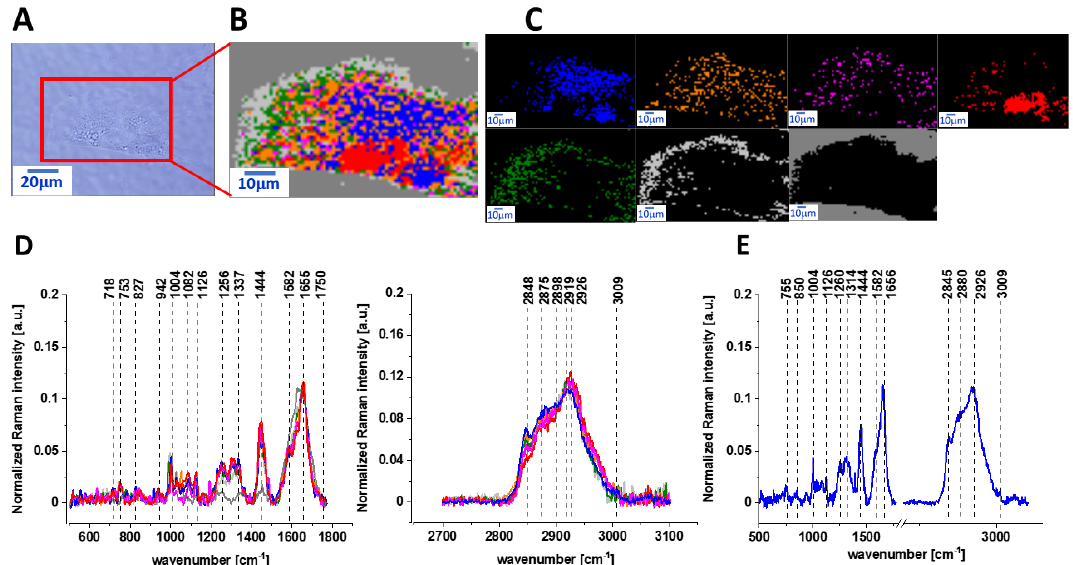
Figure 1. The microscopy image ( A ), Raman image ( B ) of human colon normal single cell CCD-18 Co constructed based on cluster analysis (CA) method; Raman images of all clusters identified by CA assigned to lipid-rich regions (blue and orange), mitochondria (magenta), nucleus (red), cytoplasm (green), cell membrane (light grey), and cell environment (dark grey) ( C ); the average Raman spectra typical for CCD-18 Co human normal colon cell for all identified clusters for low frequency and high frequency region ( D ), and the average Raman spectrum for human normal colon cells—for cells as a whole ( E ), all data for experiments performed without any supplementation, cells measured in PBS, colors of the spectra correspond to the colors of clusters; excitation laser line 532 nm; number of cells=6.